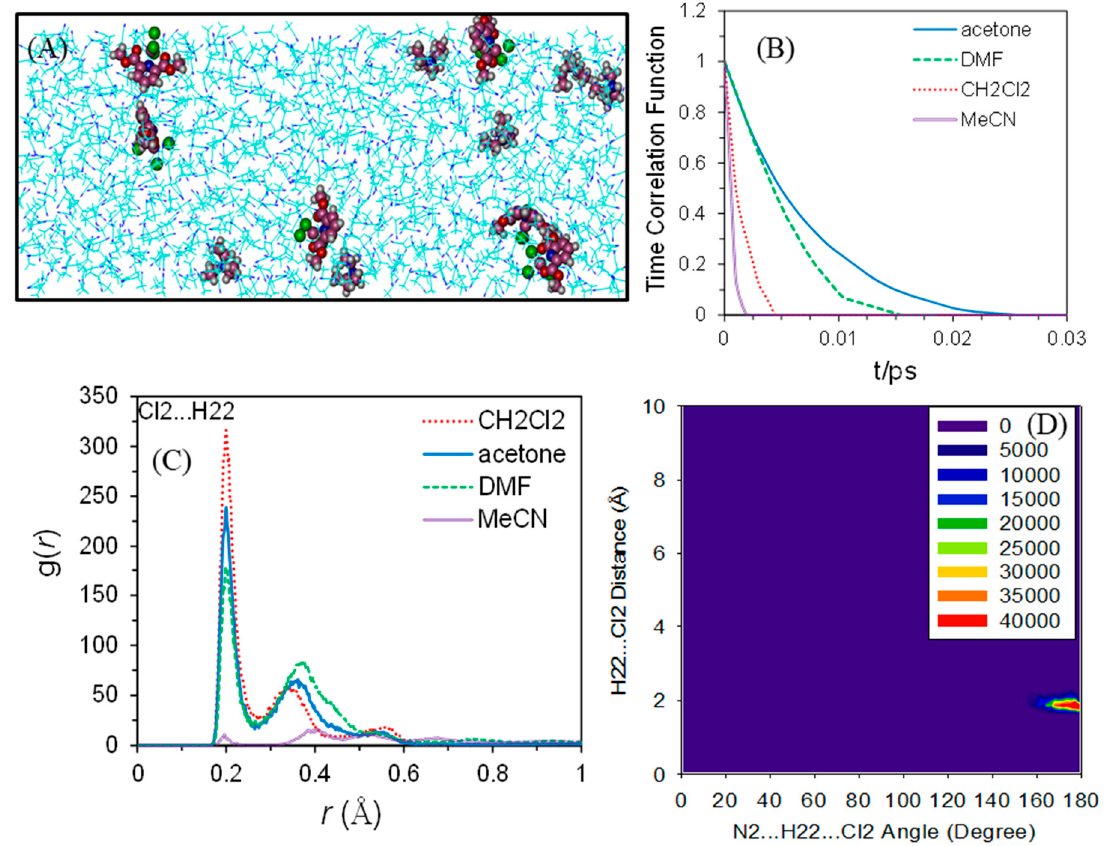
Figure 6. ( A ) Snapshots of the DFT calculated dynamic behavior of six ion pairs Figure 6. ( A )SnapshotsoftheDFTcalculateddynamicbehaviorofsixionpairs(HNEt 3 )[Cu(pydicMe 2 )Cl 3 ] (HNEt 3 )[Cu(pydicMe 2 )Cl 3 ] in MeCN. ( B ) Time correlation functions, ( C ) the radial distribution in MeCN. ( B ) Time correlation functions, ( C ) the radial distribution function, and ( D ) the combined function, and ( D ) the combined radial/angular distribution function between the Cl2 atom of the radial / angular distribution function between the Cl2 atom of the anion and H22 of the cation in anion and H22 of the cation in (HNEt 3 ) + ···[Cu(pydicMe 2 )Cl 3 ] − . (HNEt 3 ) + ··· [Cu(pydicMe 2 )Cl 3 ] −